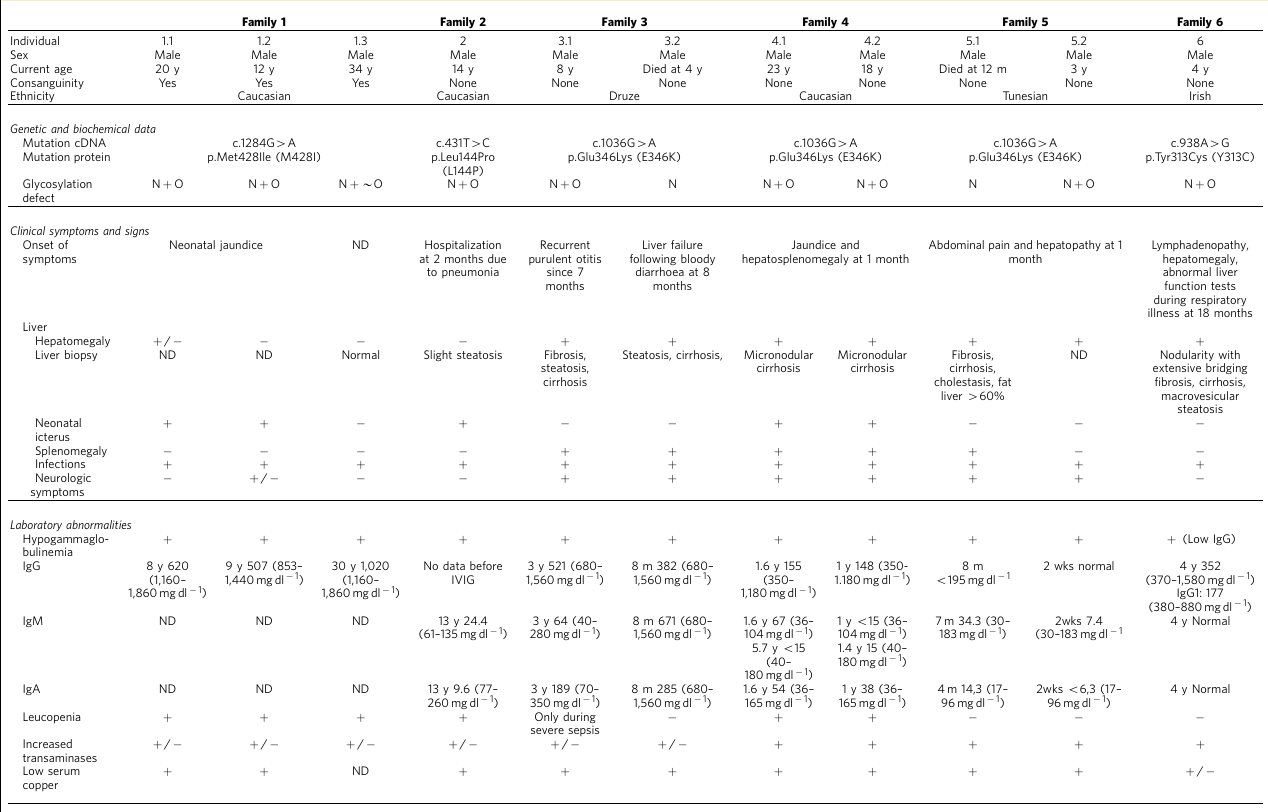
Table 1 | ATP6AP1-deficient patients: genetic, clinical and laboratory data.